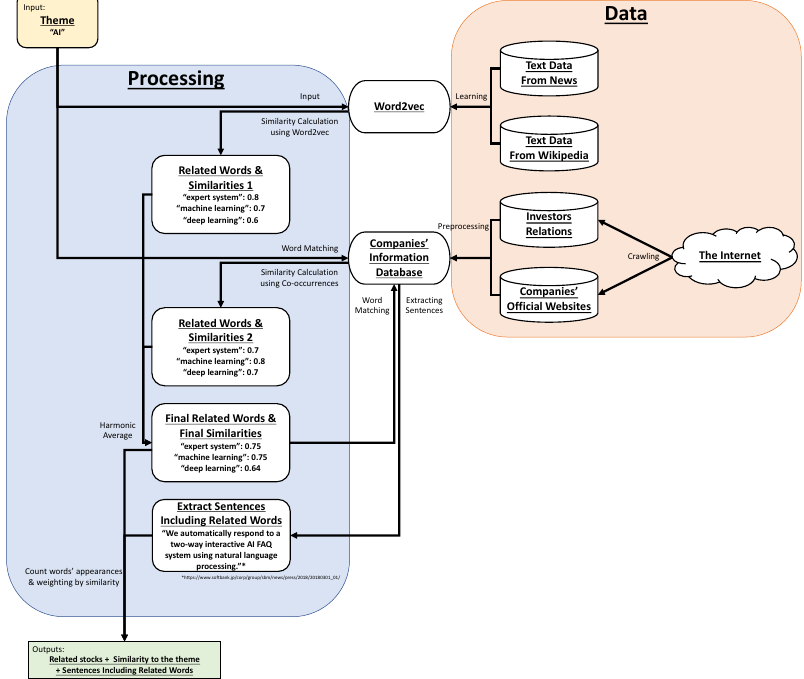
Figure 1. Scheme outline. Artificial intelligence (AI) is used as an example input